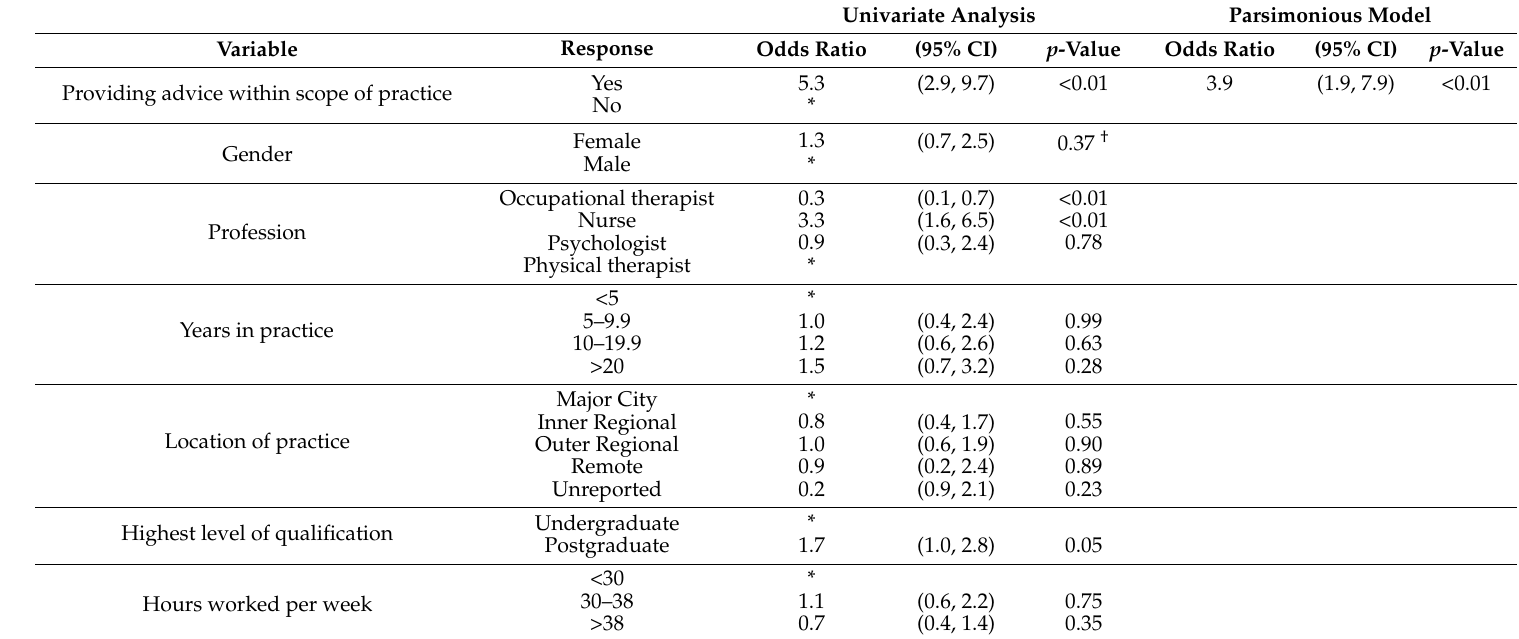
Table 4. Logistic regression modelling of factors associated with provision of dietary